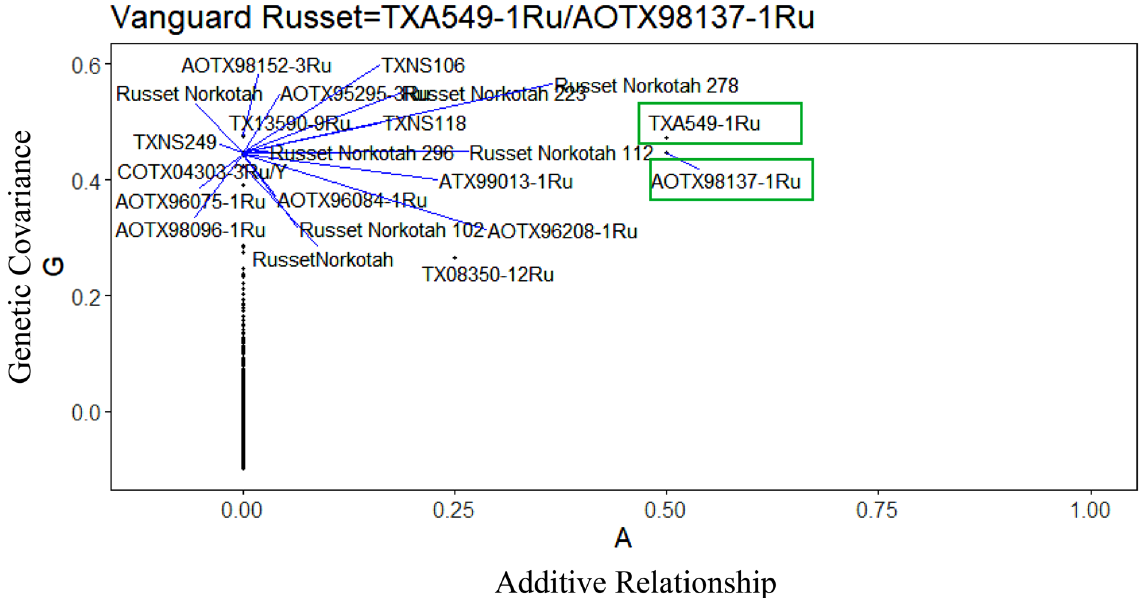
Figure 10. Population-wide comparison of genetic covariance calculated from markers with the additive relationship calculated from pedigree records, for Vanguard Russet using R software 82 .